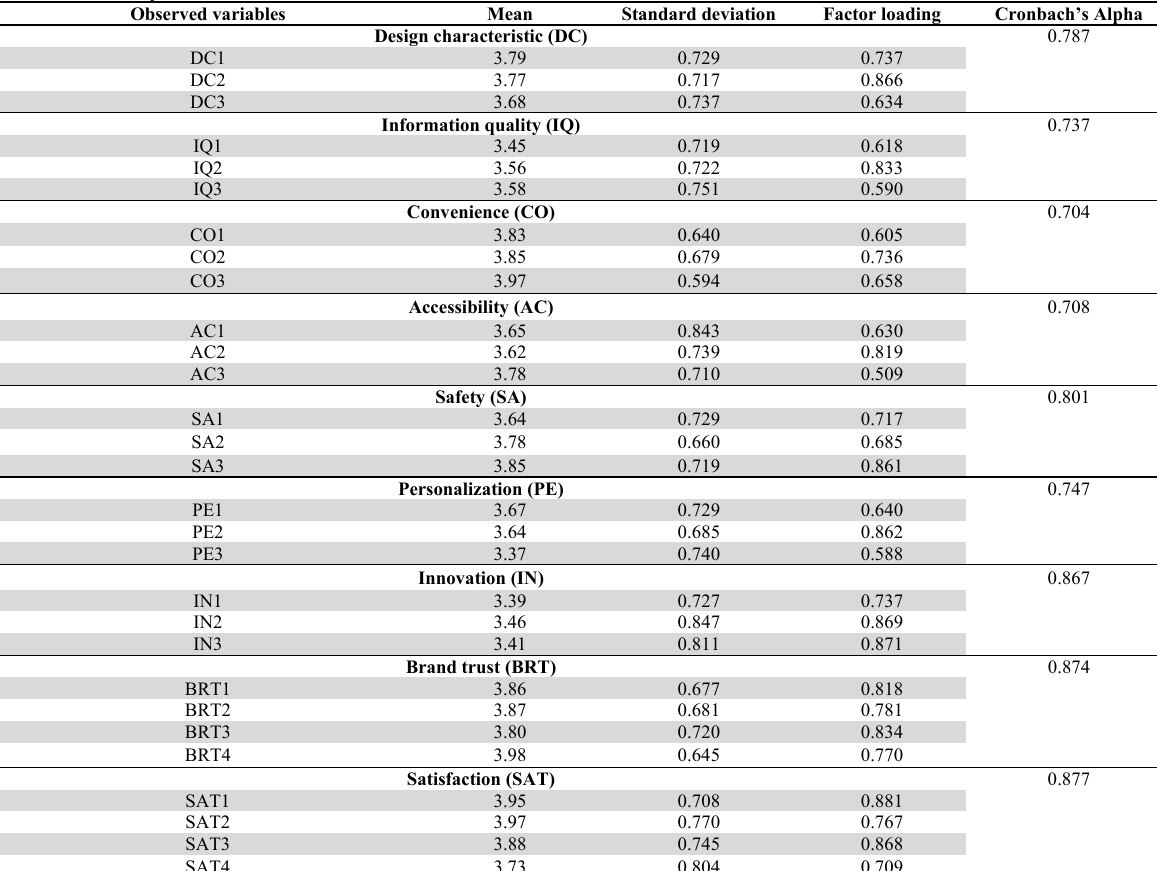
Scales’ reliability test result Observed variables